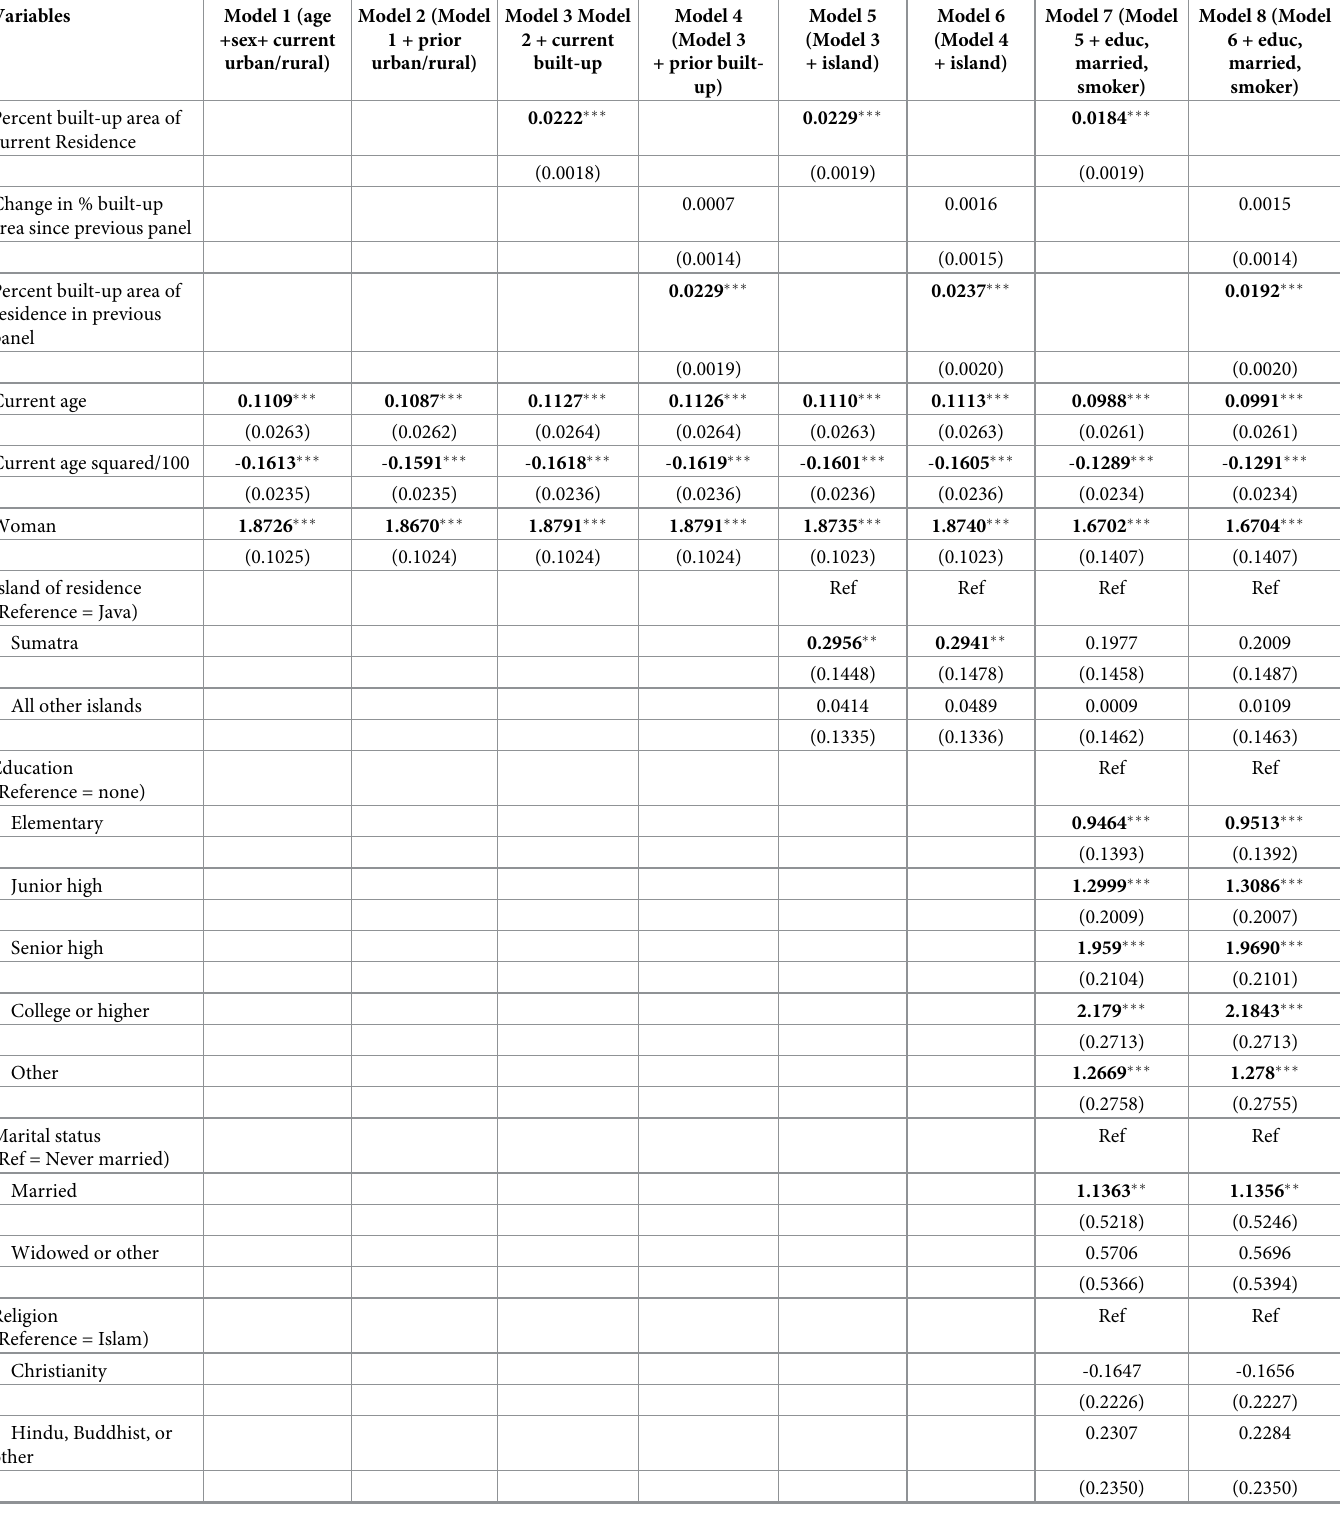
Table 3. Linear regression model predicting BMI, pooled